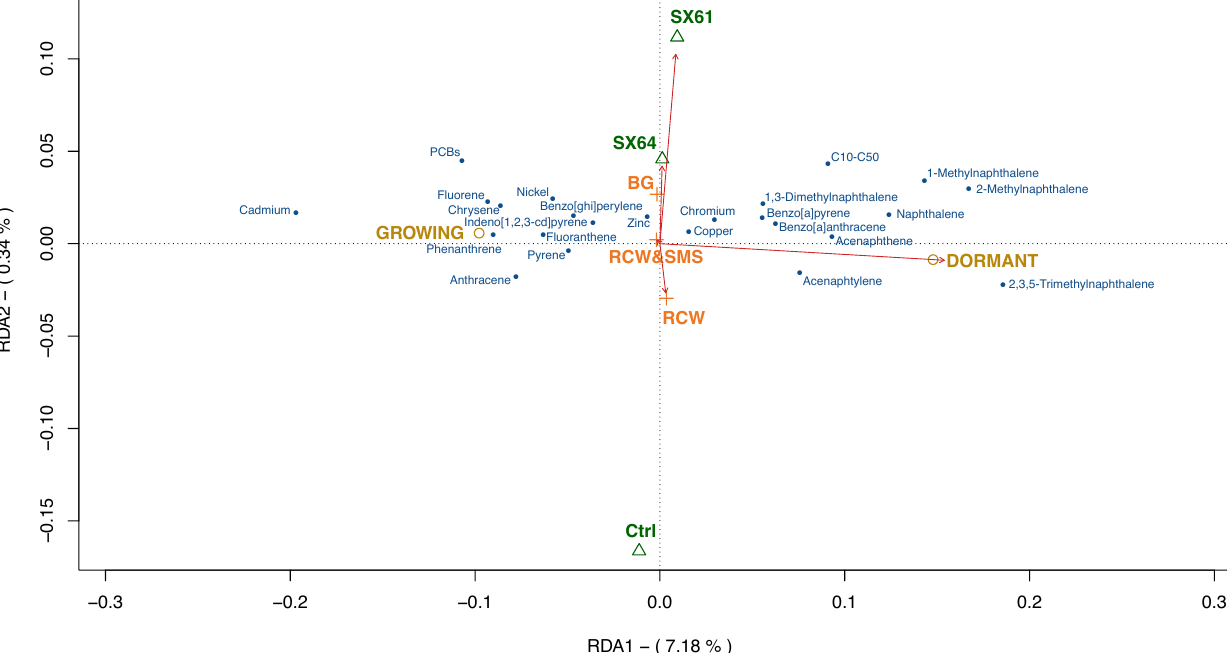
Figure 1. Redundancy analysis (RDA) showing the relationship between treatments, periods and the variation rates (VR) of contaminants in soil. Blue labels represent the VR of each “contaminant”. Green open triangles, yellow open circles and orange cross symbol represent “factor centroids” of environmental variables. Red-line arrows represent the “biplot scores” of environmental variables. The length of each arrow indicates the contribution of the corresponding variable to the contaminant variation